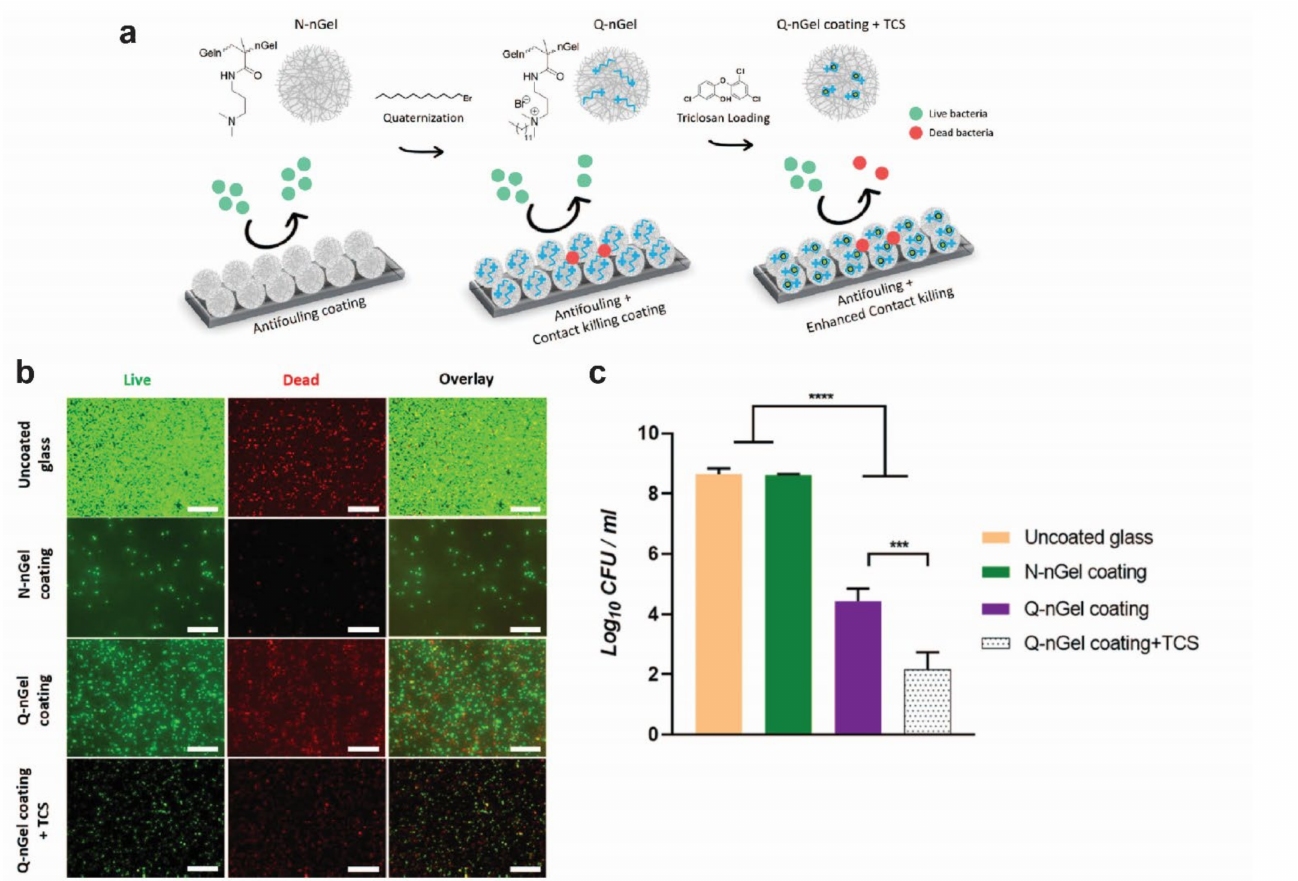
Figure 6. ( a ) Schematic overview of nanogel coating with antifouling and antimicrobial properties. ( b ) Staphylococcus aureus adhered to glass with and without the nanogel coatings under fluorescence microscopy (scale bars 20 µ m). ( c ) The number of colony-forming units of surviving Staphylococcus aureus after 24 h incubation on the surface of uncoated and coated glass (*** and **** indicate p < 0.001 and p < 0.0001, respectively). N-nGel, nonquaternized nanogel; Q-nGel, quaternized nanogel; TCS, triclosan; CFU, colony-forming units. Reprinted with permission from